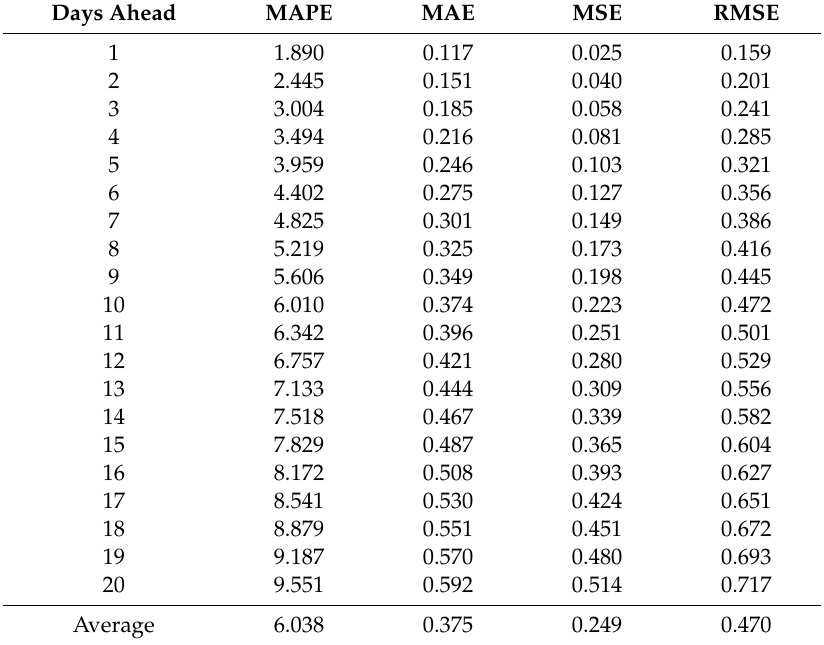
Table 6. Prediction errors of prices of CO 2 emission allowances when fluctuations of electricity prices and iron and steel prices are also used simultaneously as input